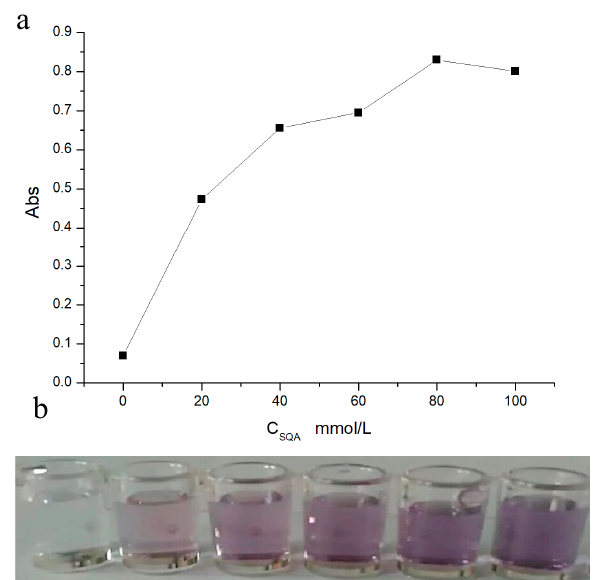
Figure 5. Absorbance curve at 537 nm ( a ) and photograph ( b ) after the reactions at different SQA concentration with iron(II) catalyzed by Au/MWCNTs. From left to right: 0, 20, 40, 60, 80 and 100 mmol/L; The iron(II) concentration: 80 mmol/L.